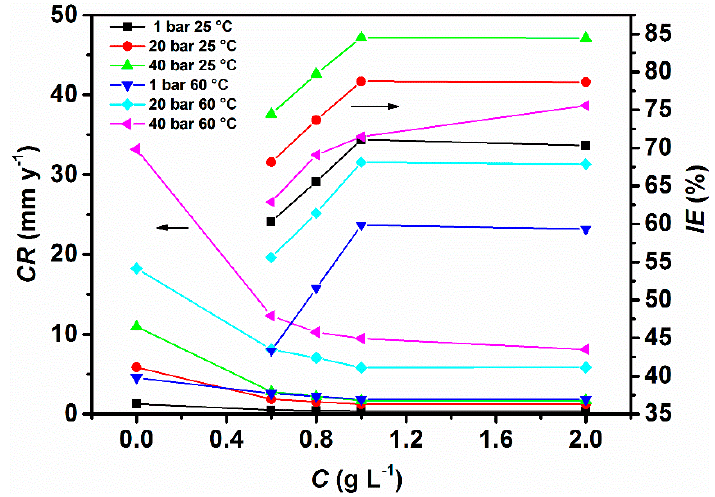
Figure 2. Corrosion inhibitor efficiency at different concentrations of gum arabic (GA) and CO 2 partial pressures after 24 h of immersion.